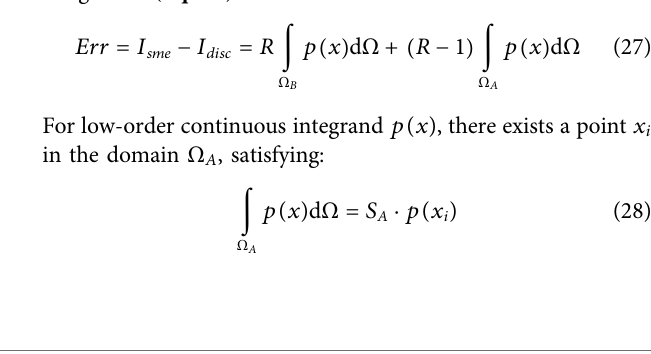
Frontiers in Earth Science |